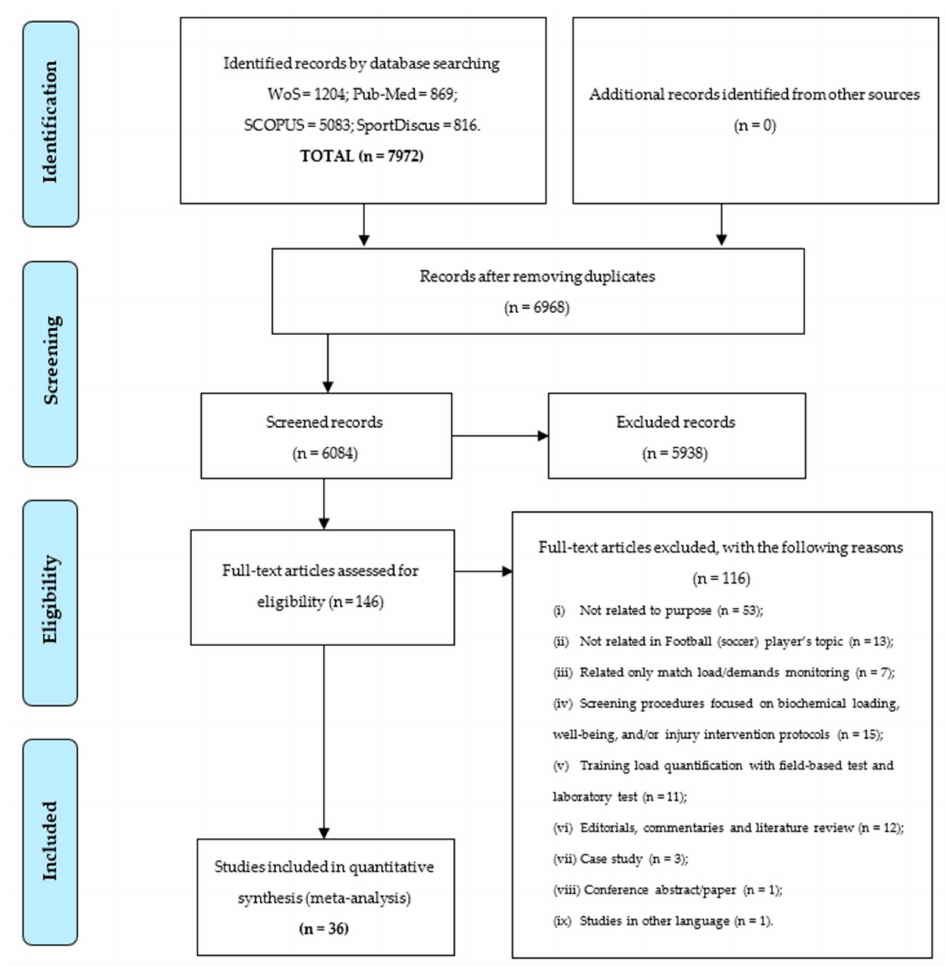
Figure 1. Preferred reporting item for systematic reviews and meta-analyses (PRISMA) flow